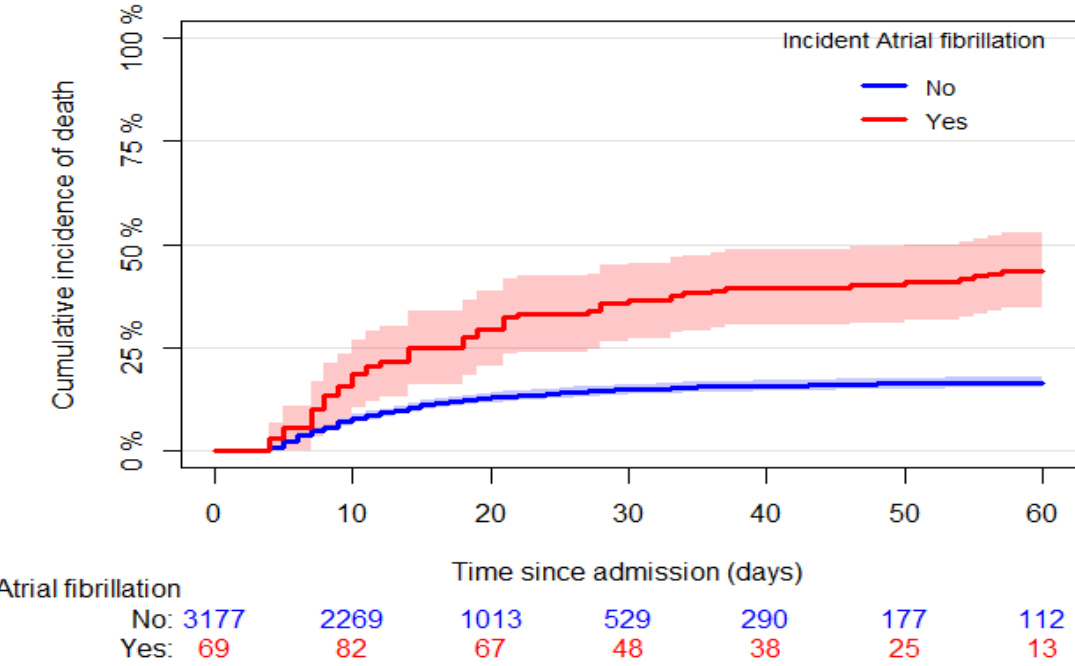
Figure 1. Crude cumulative incidence curves of the all-cause mortality in patients with and without incident AF. The origin was fixed at the median time of incident AF (3 days since hospital admission), and late entry was used for AF patients at the time of AF occurrence.